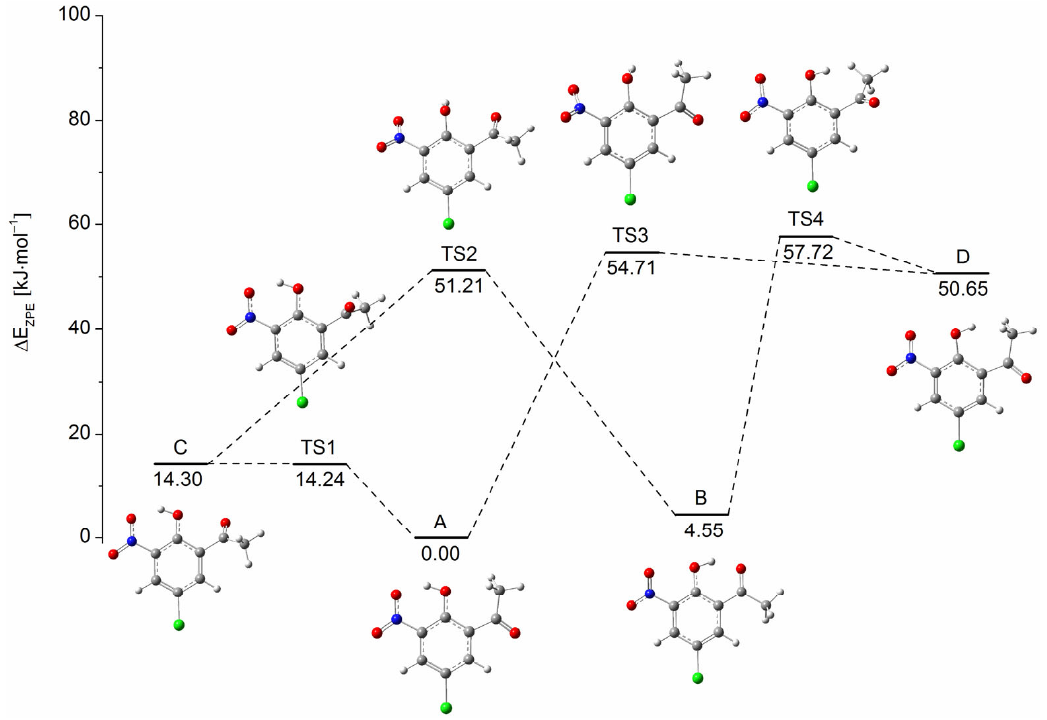
Figure 1. ZPE corrected potential energy diagram for the CNK isomerizations calculated at B3LYP/6-311++G(3df,3pd) level of theory.